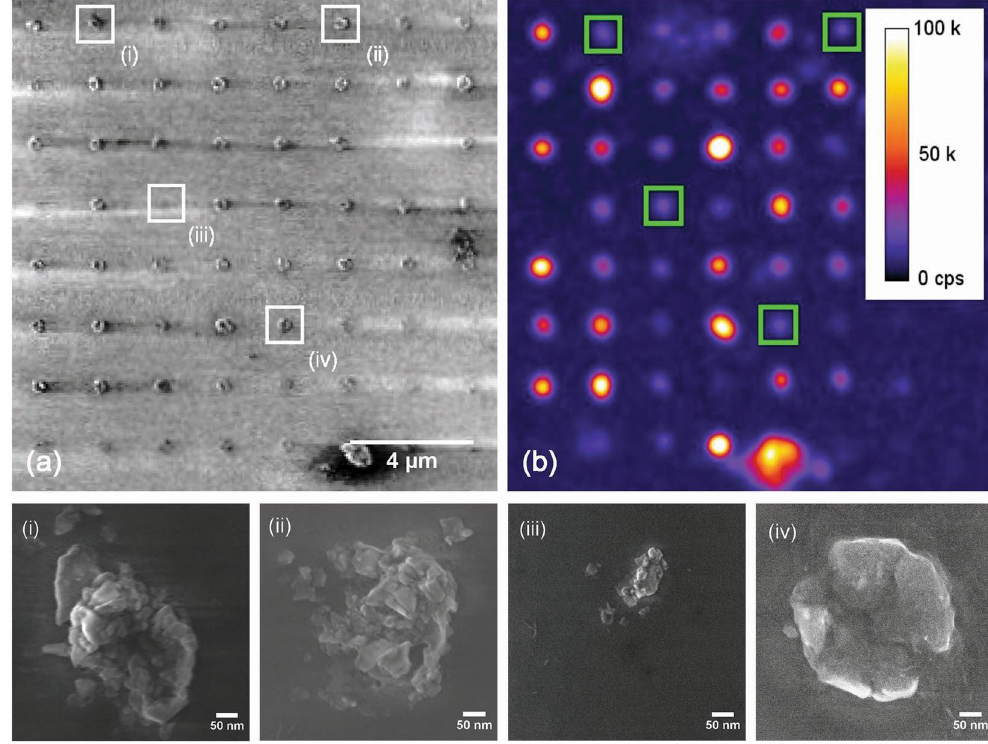
Figure 2. SEM ( a ) and confocal microscope ( b ) micrographs of one corner of array ( h ) from Fig. 1. SEM micrographs of individual sites indicated (i, ii, iii, and iv) are shown below. The comparison of SEM to confocal micrographs highlights the variation of fluorescence from nanodiamond to nanodiamond: even though site (iii) has fewer particles than the other three, they all show similar fluorescence (~25 k counts per second).